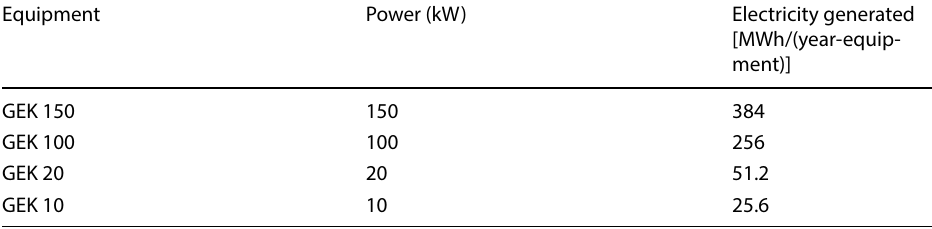
Table 1 Gasifier type and size